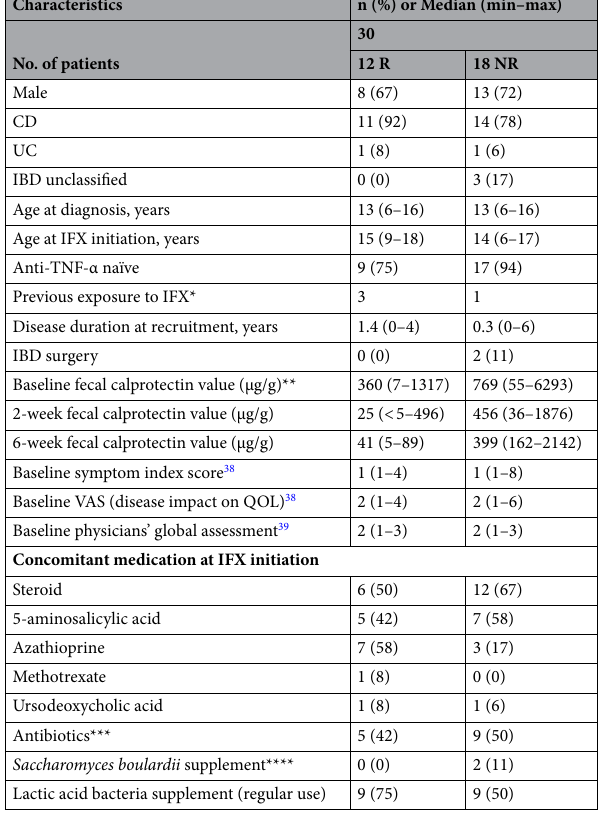
Table 1. Patient characteristics. CD Crohn’s disease, UC ulcerative colitis, IBD inflammatory bowel disease, IFX infliximab, TNF tumor necrosis factor. *Time since exposure at baseline 10–26 months. **Three patients